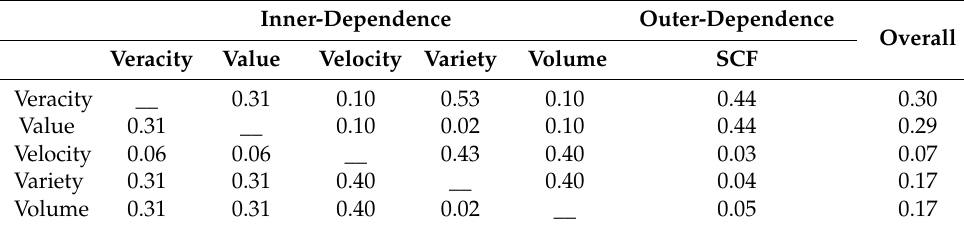
Table 4. Fuzzy analytic network process